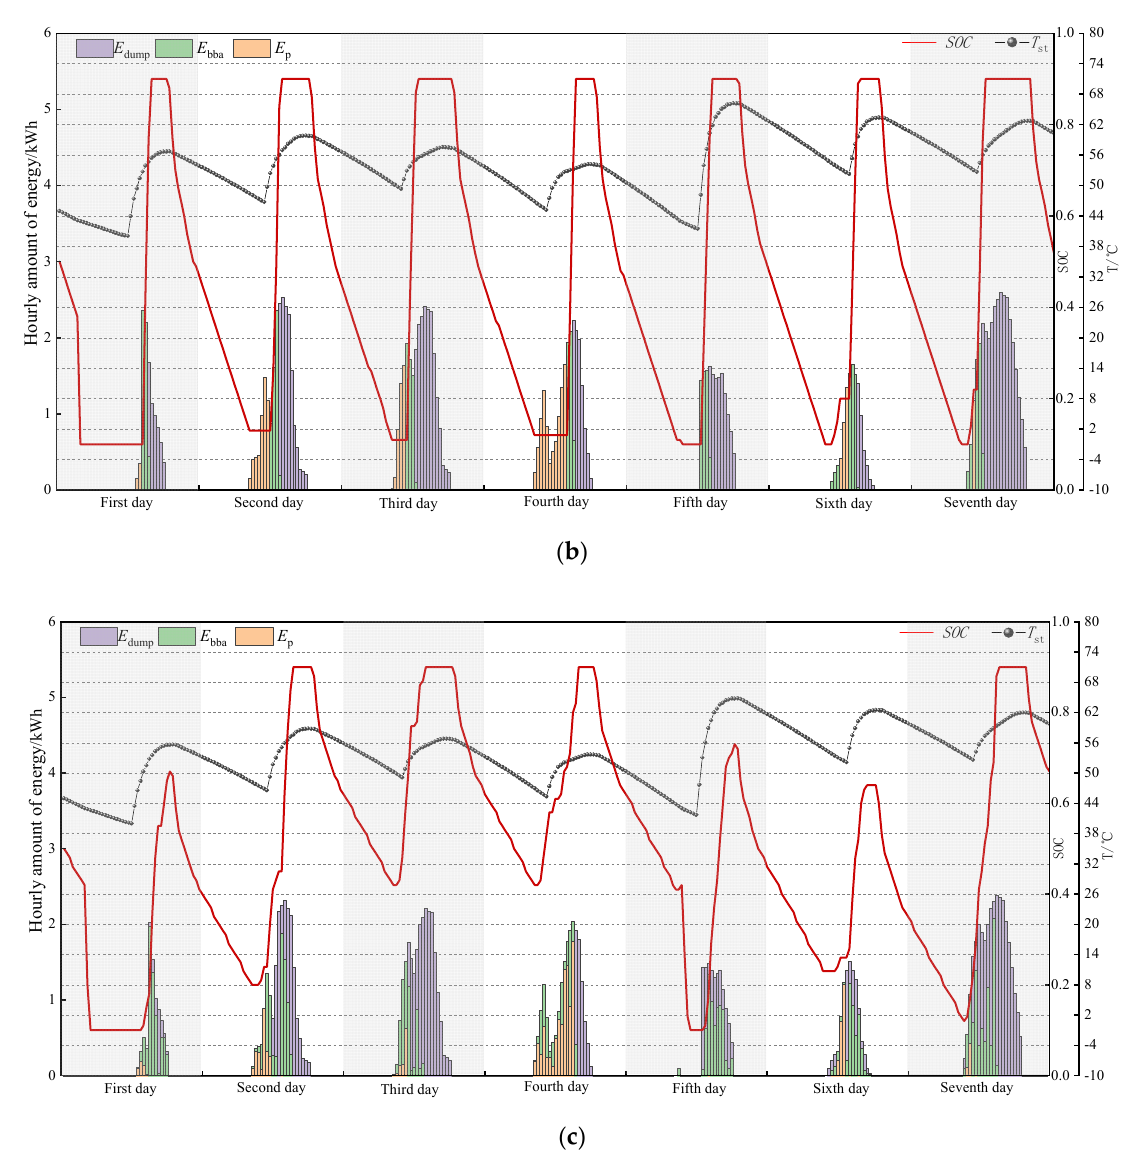
Figure 10. System operation optimization results under different operating strategies. ( a ) Strategy C; ( b ) strategy D; ( c ) dynamic operation strategy.